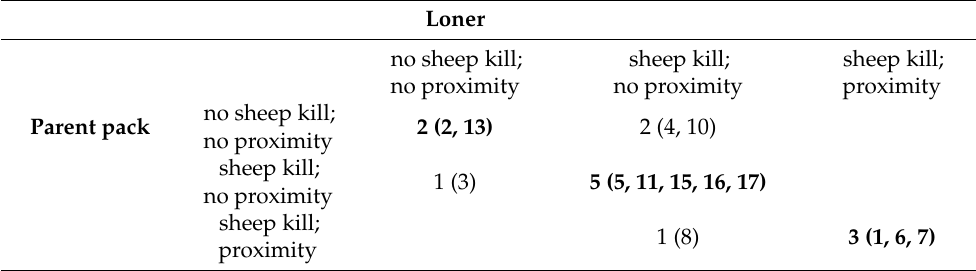
Table 4. Frequency distribution of sheep kill and proximity to humans characteristics of 14 identified Dutch loners and their parent packs at the time the loners were reared (bold: similar behavior; loner nr in